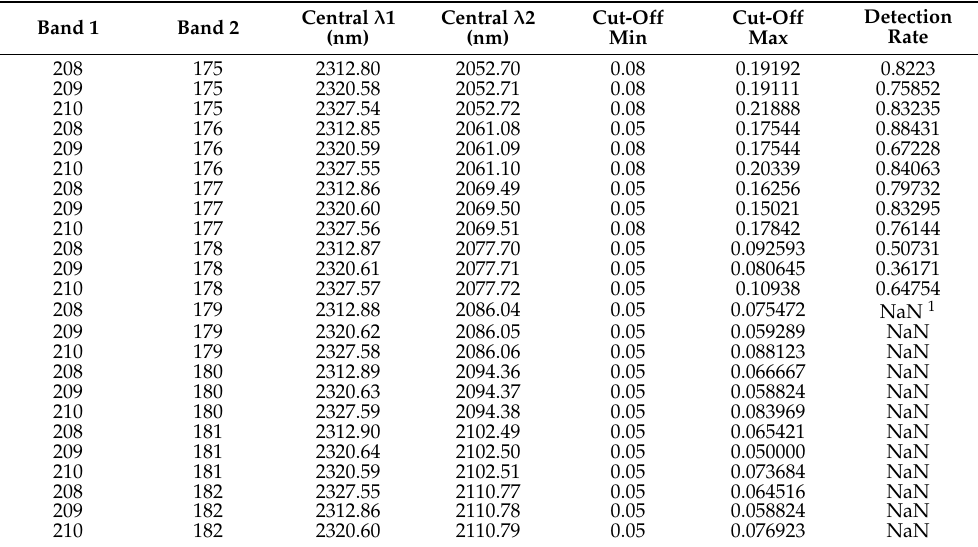
Figure 8. Separability of Ben Halls Gap National Park fire indices HFDI mean value over the twenty-four combinations is 0.0778 ± 0.0265, and the background is 0.0117 ± 0.0080.